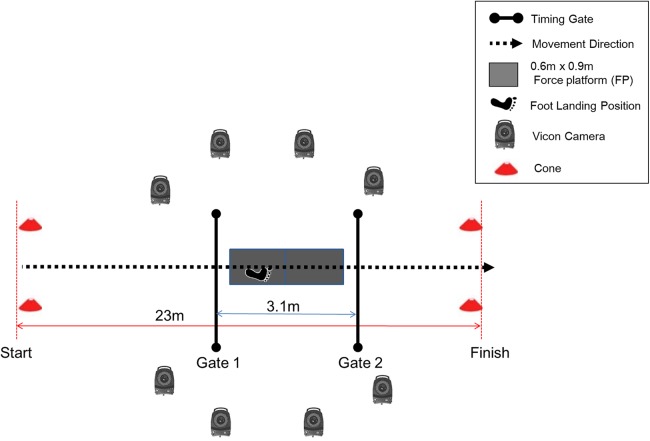
Experimental setup.